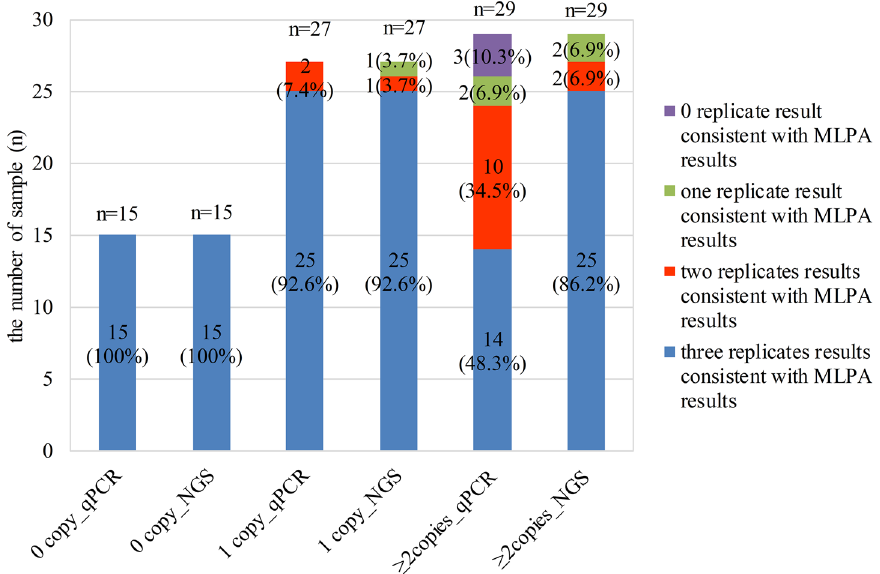
Figure 3. The consistency of repeated experiments compared with the MLPA results. Horizontal axis represents the conditions of 0 copy, 1 copy and ≥ 2 copies of SMN1 gene detected by qPCR and NGS methods, respectively. Each bar chart represents the sample number used for repeatability study. In each bar chart, blue, red, green, and purple represent samples with three, two, one and 0 replicates result that consistent with MLPA results,